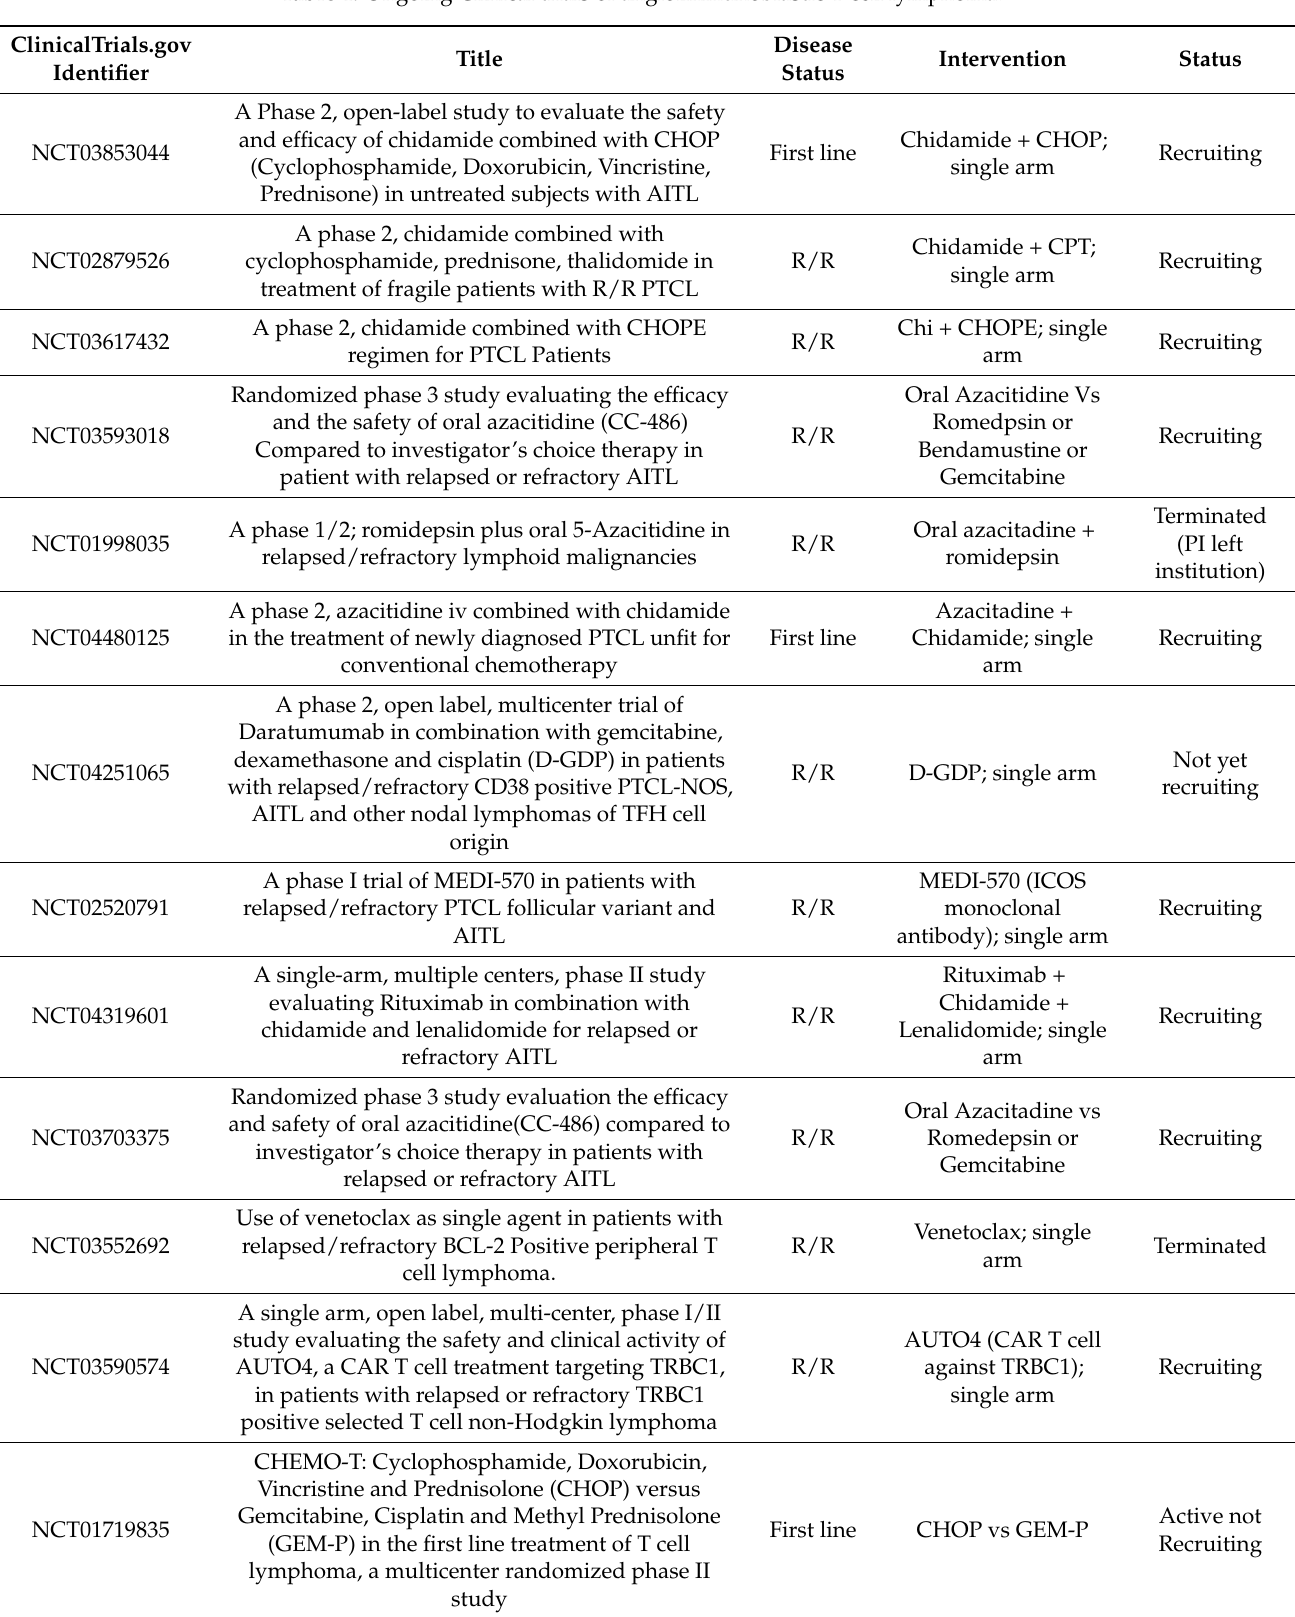
Table 4. Ongoing Clinical trials of angioimmunoblastic T cell lymphoma.